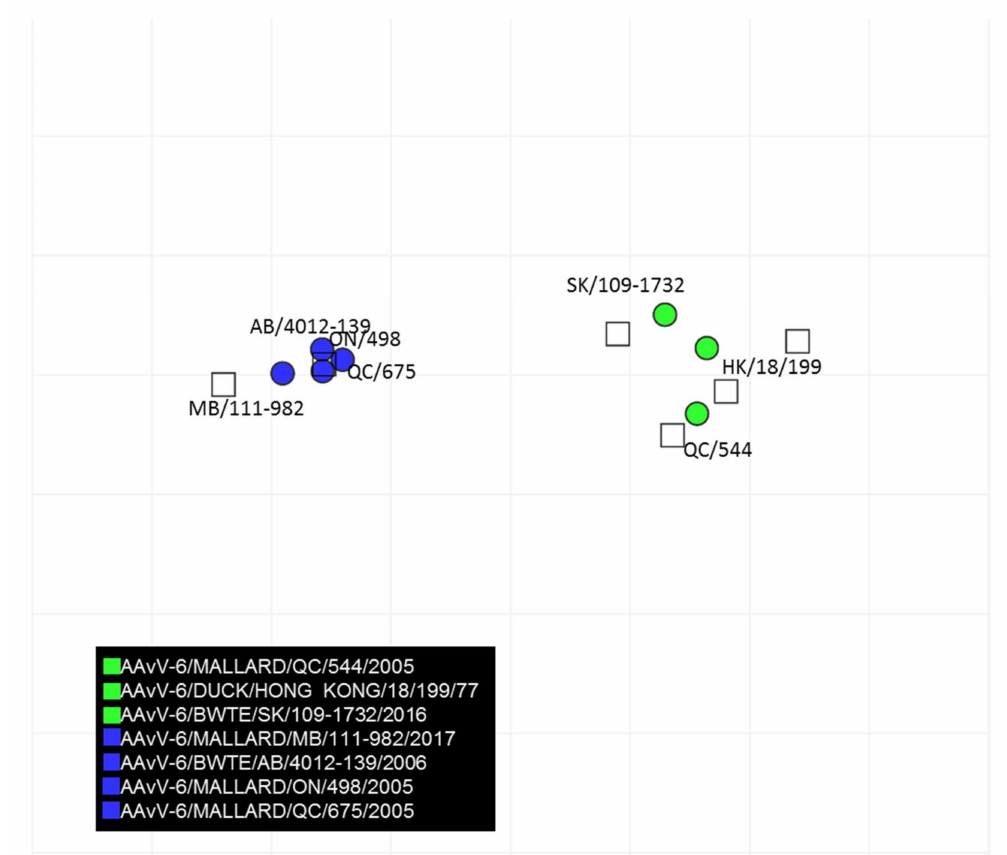
Figure 4. Antigenic map developed based on cross-hemagglutination inhibition test results of AAvV- 6 viruses and antisera developed to each genotype of AAvV-6. The vertical and horizontal axes represent the antigenic distance and the spacing between each grid lines represents a distance of 1 antigenic-unit distance which corresponds to a 2-fold dilution in the HI